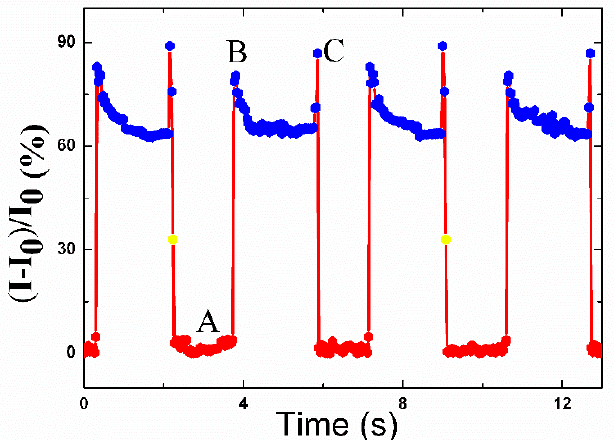
Figure 9. Response of the strain sensor with spring-like configuration worked as wearable sensors in monitoring the stability of forefinger bending. A: The relaxing state of the strain sensor at the point the forefinger was bent suddenly. B: The maximum relative current variation of the strain sensor to the response of bending the forefinger. C: The bending state of the strain sensor at the point the forefinger recovered to the relaxing state suddenly.